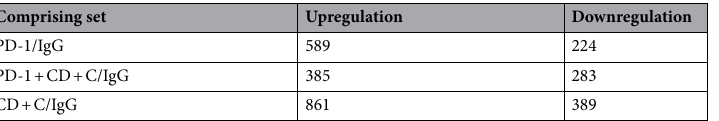
Table 1. Gene chip analyses of gene expression in CT26 tumor grown in BALB/c mice revealed involvement of more than 1250 differentially expressed genes.